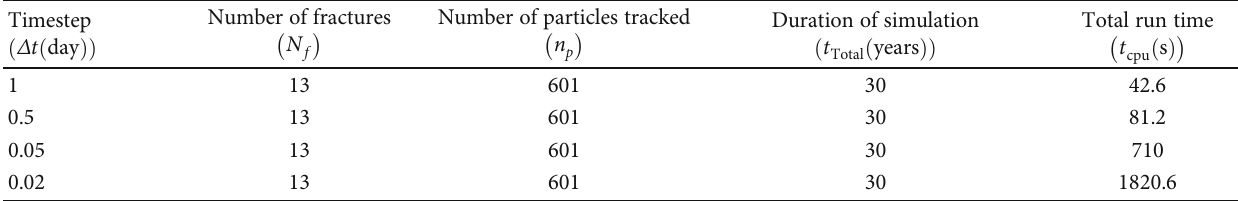
) for several test cpu